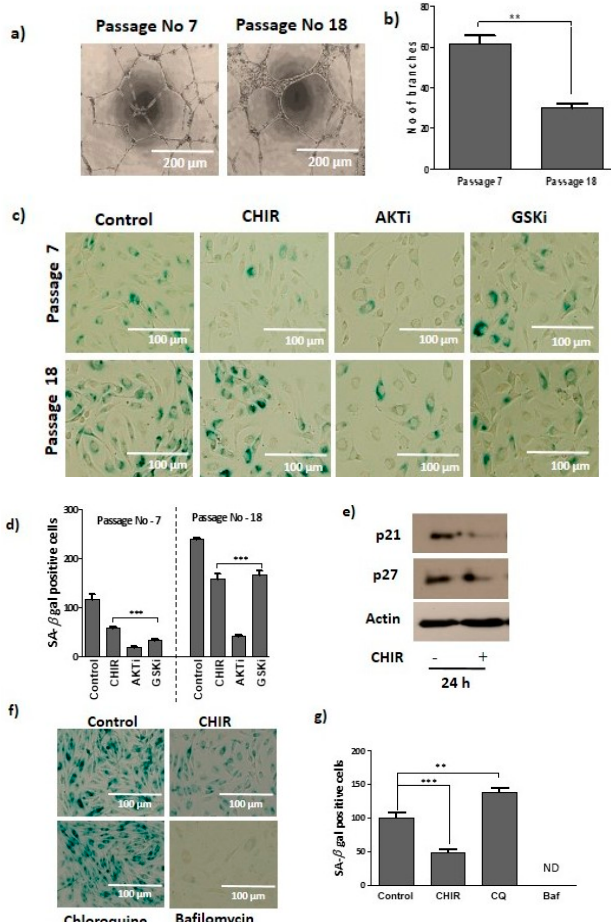
Figure 5. Late EPCs senescence repressed by lysosome activation and autophagy. ( a ) The formation of vascular structure was compared with young (p-7) and old (p-18) passage numbers of late EPCs. ( b ) The number of branches was quantified by young (p-7) and old (p-18) cells. ( c ) The cells were treated with CHIR99021 (3 uM) and GSK-3 β inhibitor (3 uM) for 24 h, and AKT 1/2 inhibitor (3 uM) for 1h, at different passages (p-7, p-18). Following this, the cells were stained to detect senescence by β -galactosidase according to the manufacturers’ instructions. ( d ) The senescence-positive cells were quantified. ( e ) Cells were stimulated with CHIR99021 (3 uM) for 24 h, and senescence marker proteins p21 and p27 and loading control actin expression was observed using Western blots. ( f ) After selective treatment with CHIR99021 (3 uM), chloroquine (20 uM) and bafilomycin A1 (5 nM), cells were stained with β -galactosidase. ( g ) The senescence-positive cells were captured and quantified. Data are presented as mean ± standard error of the mean (SEM). The results are considered statistically significant at ** p < 0.01; *** p < 0.001 when compared to untreated groups. (Baf—bafilomycin A1,